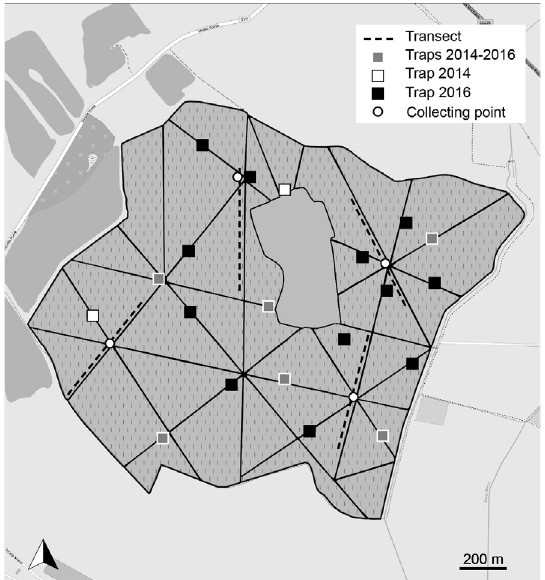
Figure 9. Map of Bosco della Fontana with the sampling sites (black dotted lines: transects for Sightings, Remains and Net-transect; white dots: clearings for Net-point; grey squares: trap sites in 2014 and 2016; black squares: trap sites in 2016; white squares: trap sites in 2014).